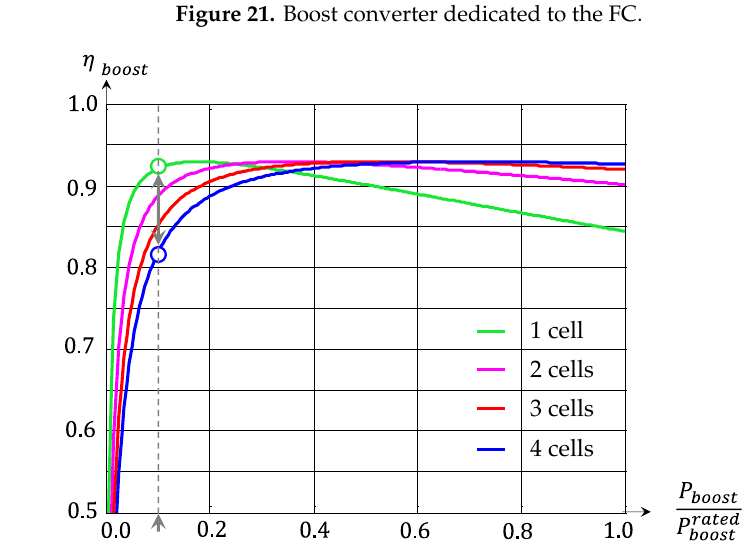
Figure 22. E ffi ciency curves of the FC interleaved boost Figure 22. Efficiency curves of the FC interleaved boost converter.